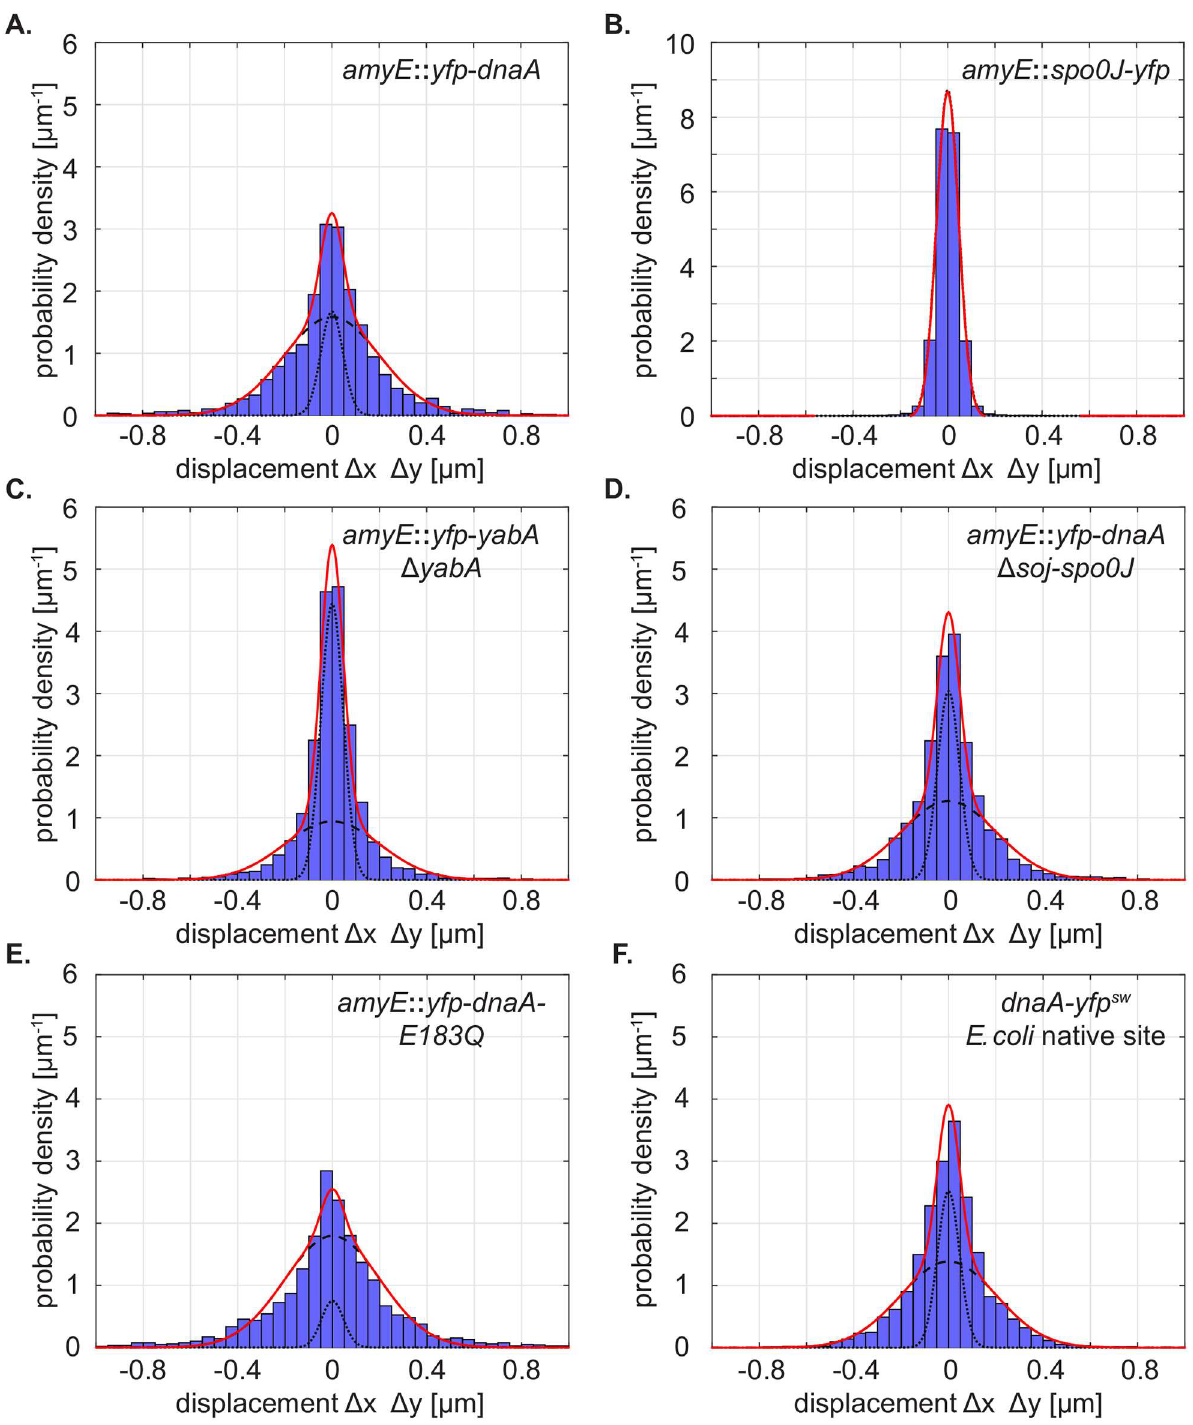
Fig 6. Mobility of proteins analyzed by single molecule tracking. Shownare histograms of frame-to-frame displacements in x- and y- directions. To calculatethe populationsize and the diffusion coefficients of the individual populations,the distributionswere fitted by a Gaussianmixture model. The red line represents the sum of the two Gaussiandistributions, and the dotted and dashed lines represent the singleGaussian distributions that correspond to the slow and fast mode of motion. A) YFP-DnaA expressedfrom the ectopic amyE locus under the control of a xylose induciblepromoter. B) YFP-Spo0J expressedfrom the ectopic amyE locus under the control of a xylose inducible promoter. C) YFP-YabA expressed from the ectopic amyE locus under the control of a xylose inducible promoter in a strain deletedfor YabA. D) YFP-DnaA expressed from the ectopic amyE locus under the control of a xylose inducible promoter in a strain